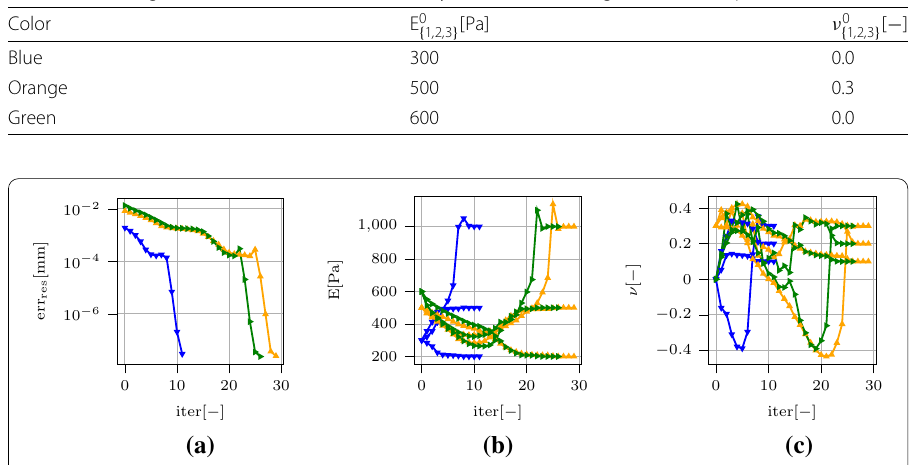
Fig. 11 Result of Inverse analysis for noise free data. Development of a residual error err res , b Young’s modulus E, c Poisson’s ratio ν over iterations for different initial guesses